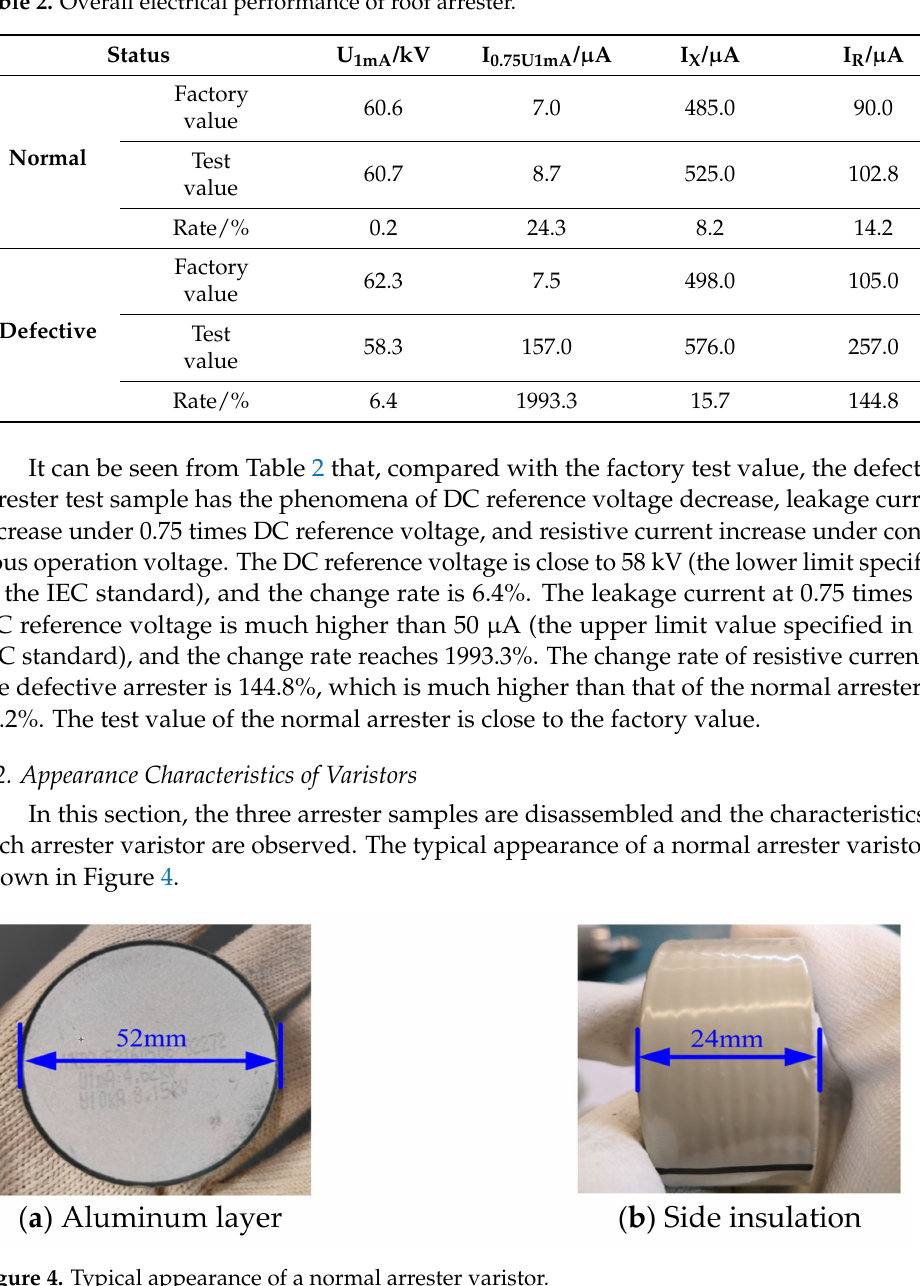
Table 2. Overall electrical performance of roof arrester.